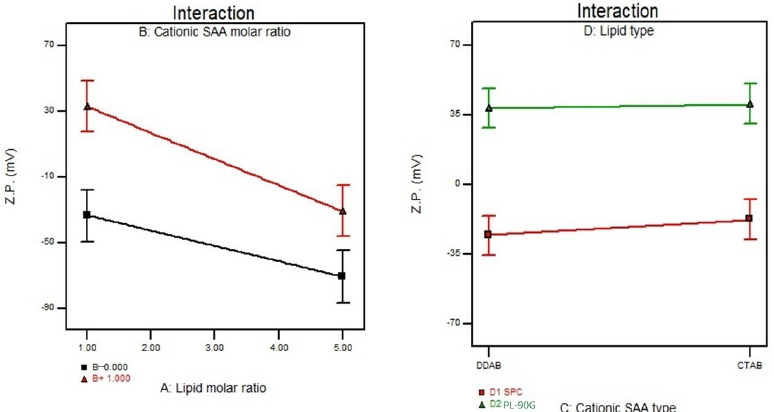
Figure 3. The effect of lipid molar ratio (X 1 ), cationic surfactant molar ratio (X 2 ), cationic surfactant type (X 3 ), and lipid type (X 4 ) on Z.P. Abbreviation: Z.P., zeta potential. type (X 3 ), and lipid type (X 4 ) on Z.P. Abbreviation: Z.P., zeta potential.